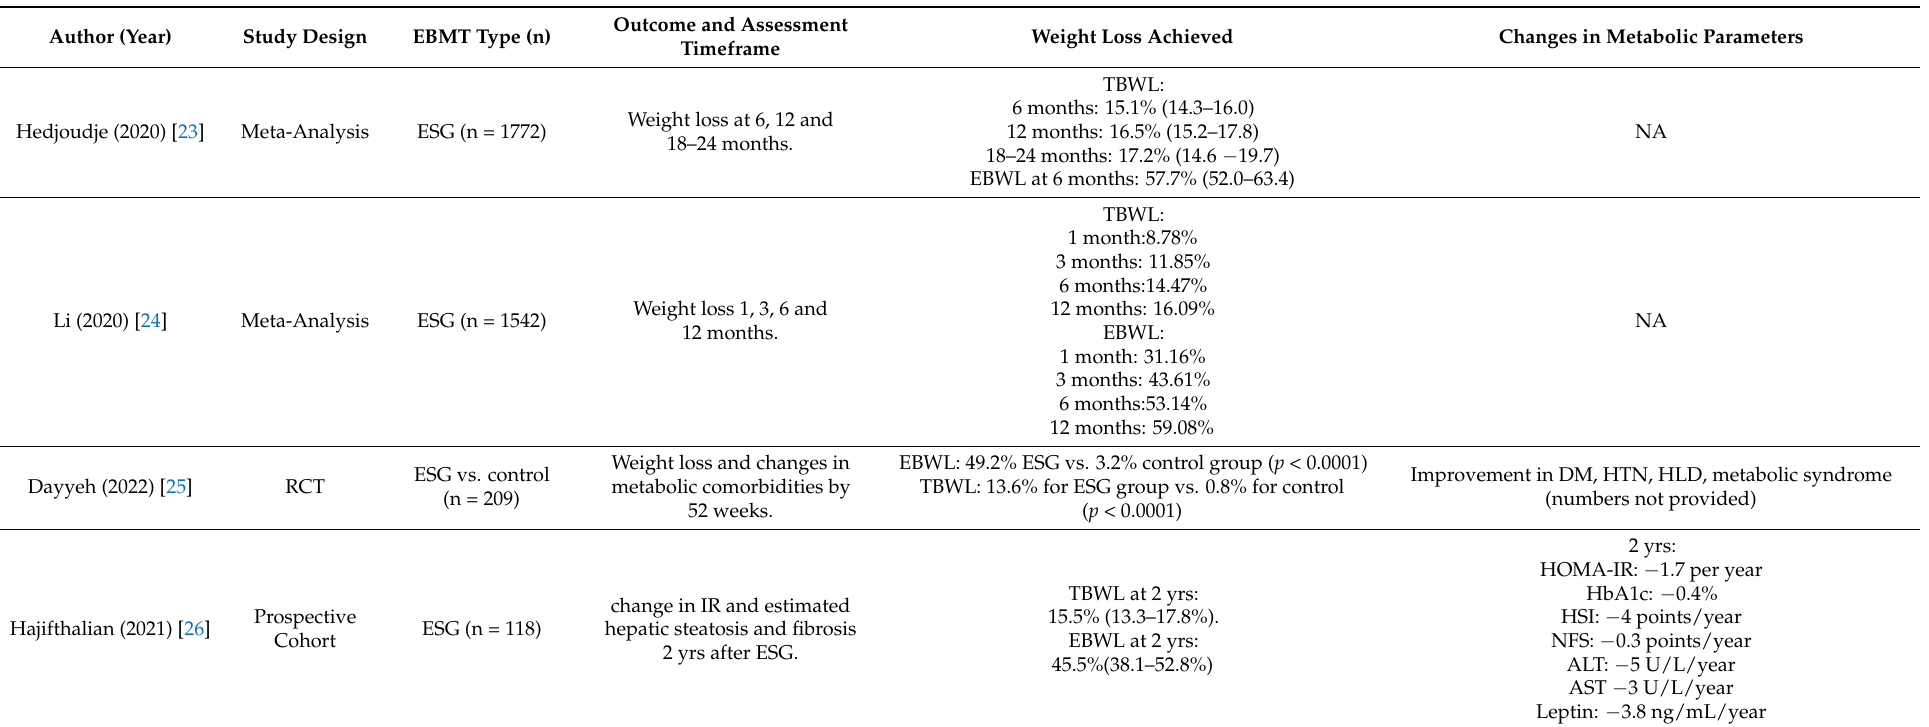
Table 2. Weight loss with Endoscopic Sleeve